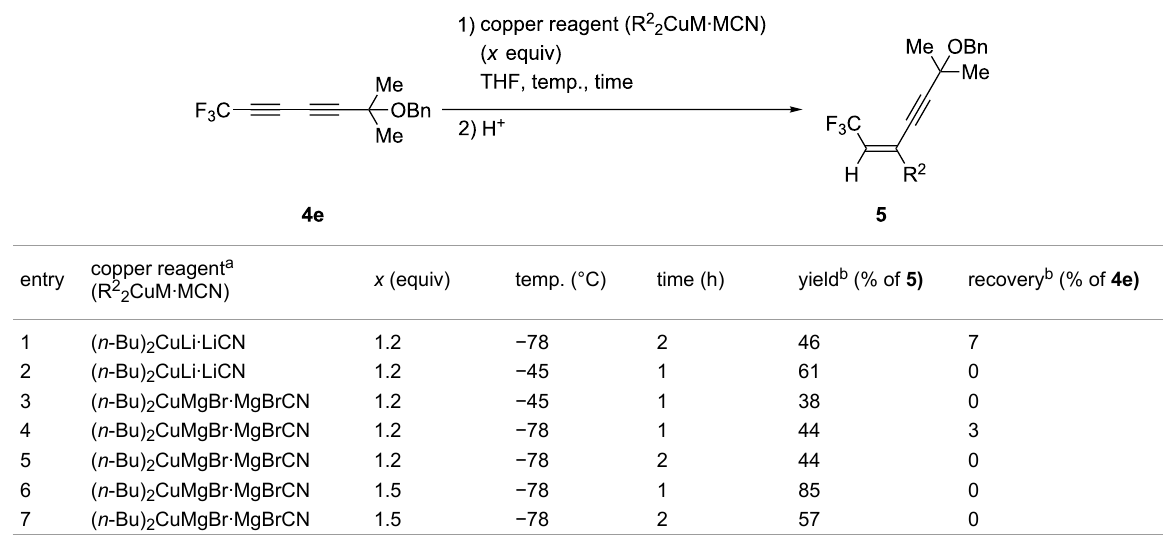
Table 3: Investigation of the reaction conditions in carbocupration.